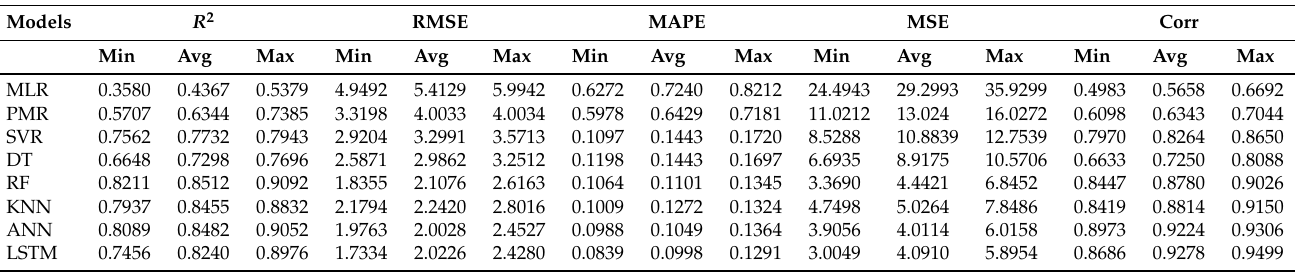
Figure 10. Measured and predicted path loss and the prediction error of all the ML-based models. ( a ) Measured and predicted path loss; ( b ) Prediction error. Table 4. Performance metrics after removing the antenna height and the AoA from the input features of the